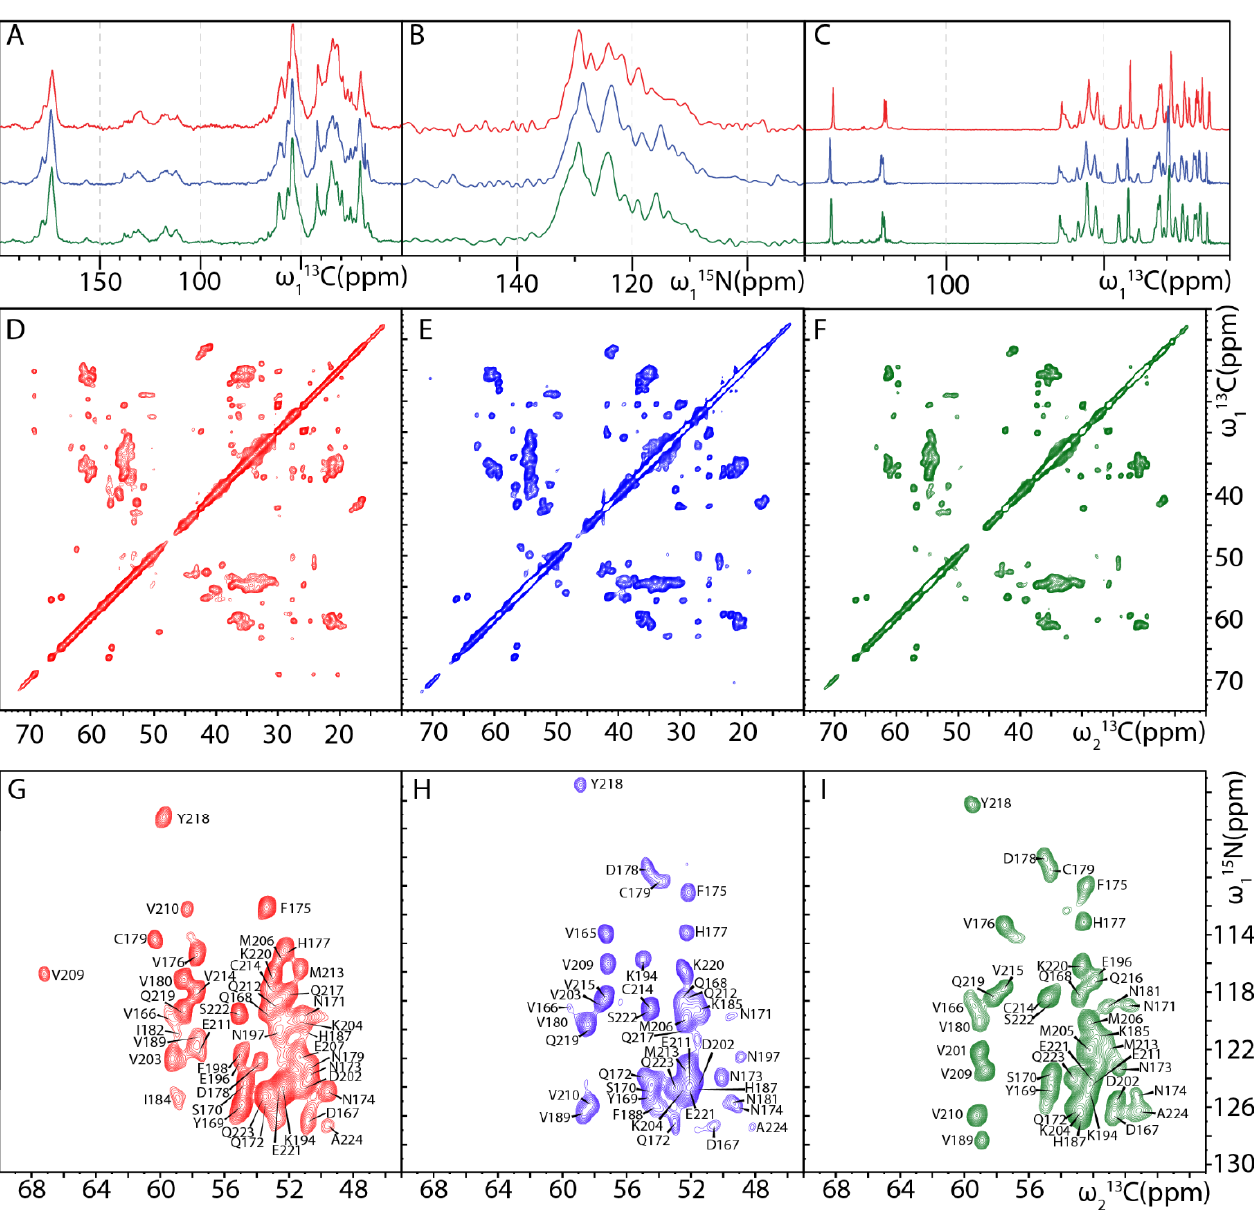
Figure 2. MAS NMR spectra of U ‐ 13 C, 15 N ‐ labeled Thr ‐ , Arg ‐ selectively unlabeled MoPrP(89 ‐ 230) fibrils. Spectra of fibrils aggregated in U3G1 condition are colored red, in G2 condition—blue and in G4 condition—green. 1D 13 C CP ( A ), 15 N CP ( B ), 13 C INEPT spectra ( C ), 2D DARR spectra ( D – F ) and assigned 2D NCA spectra ( G – I ) were recorded at 800 MHz and 273 K with 12.5 kHz MAS. Due to sequence discrepancy between mouse and human prions, in this figure and further, human prion protein residue numbering is adapted.